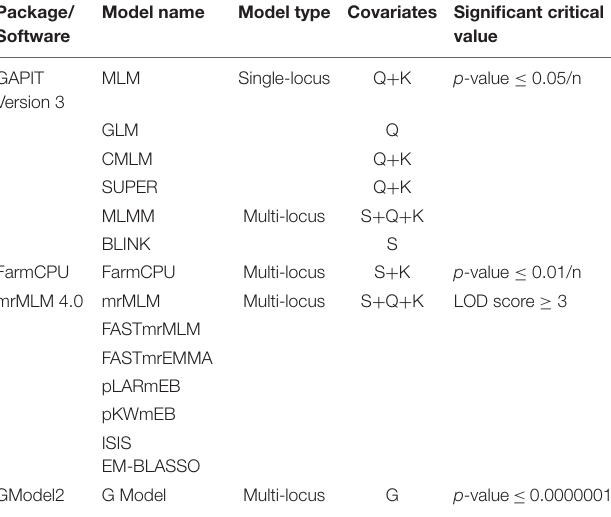
TABLE 1 | Models used for GWAS